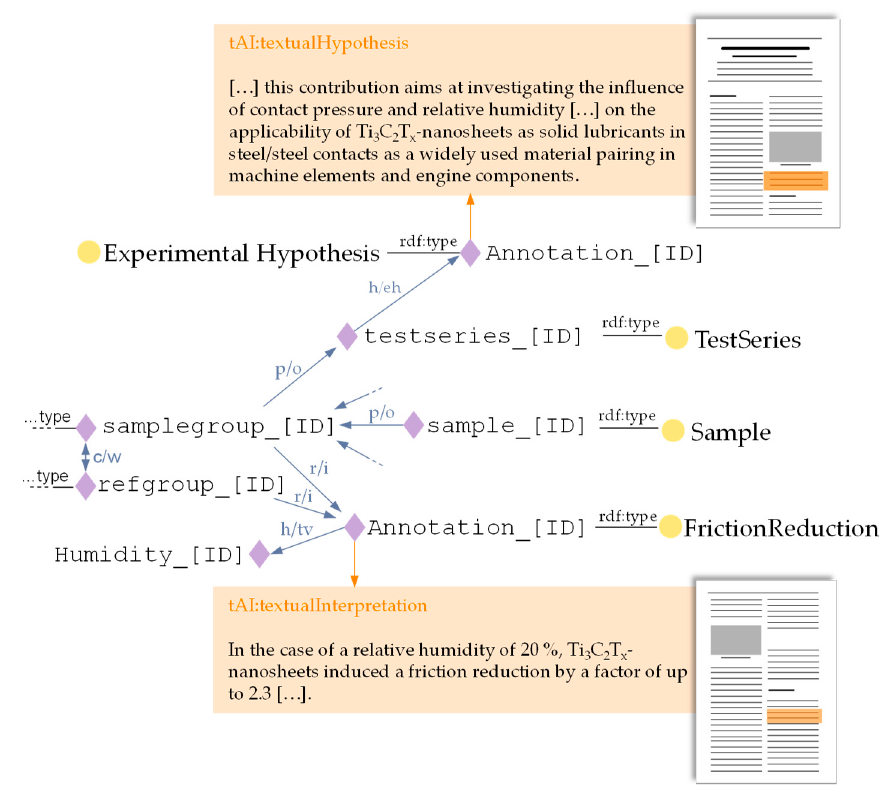
Figure 10. Linking annotations from a publication to tribAIn concepts.